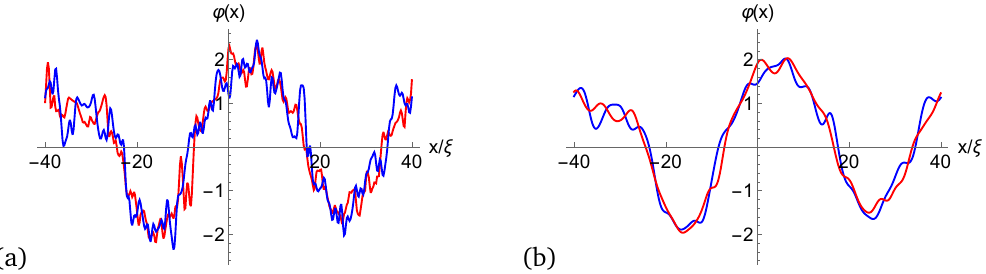
= 16ms, and for a different 1